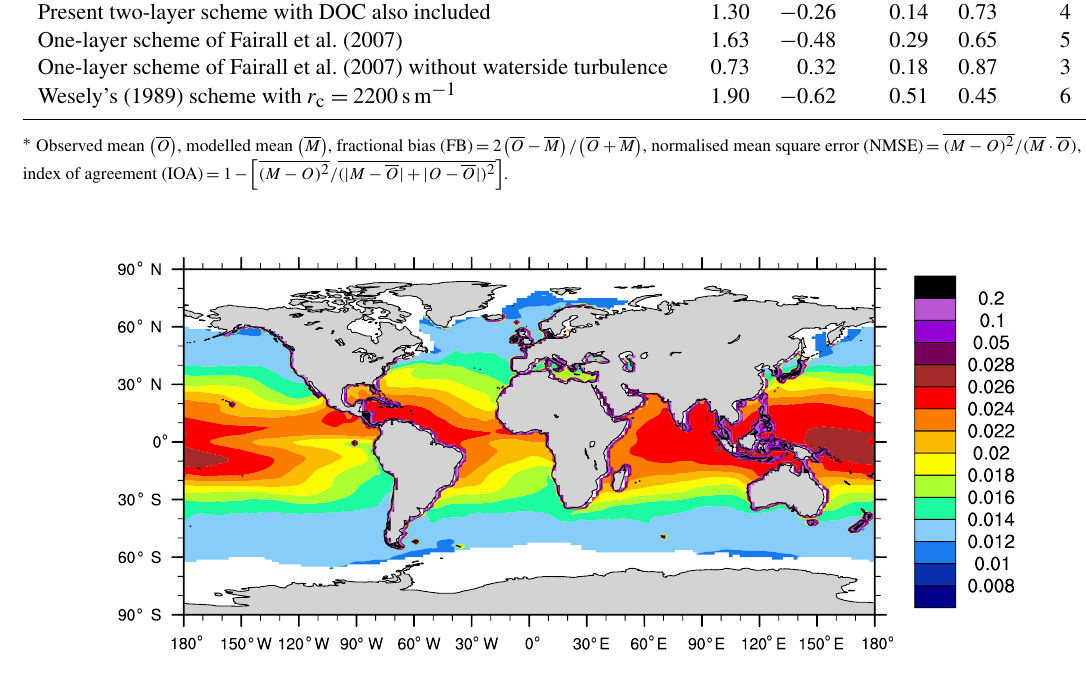
Figure 9. Annual mean ozone dry deposition velocity ( v d , cms − 1 ) to the ocean for the year 2005 obtained from the ACCESS-UKCA model incorporating the oceanic dry deposition scheme proposed in this paper. Deposition velocities over the coastal grid boxes are also